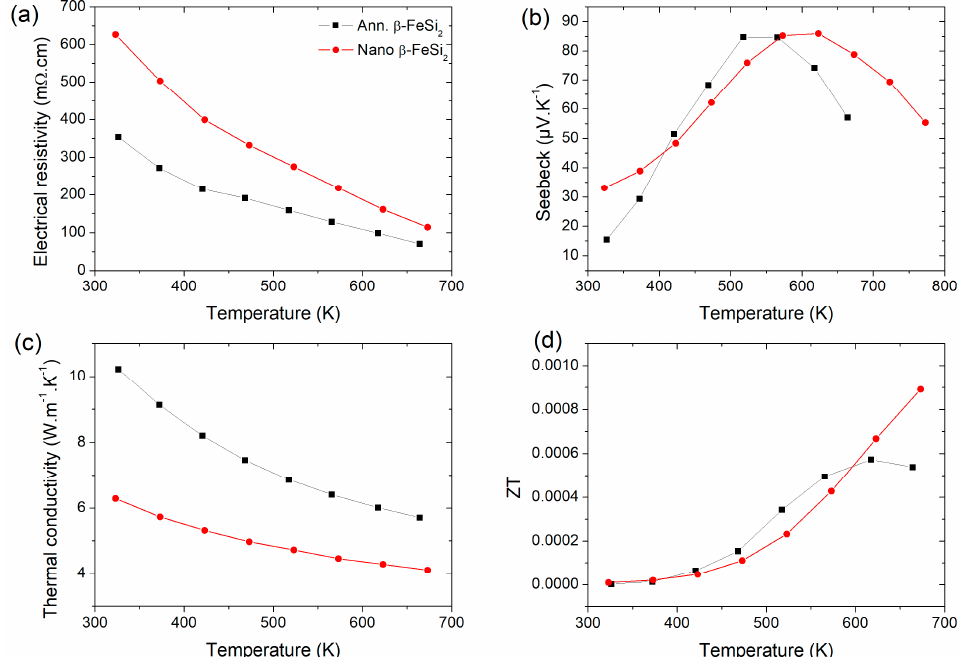
Figure 6. ( a – c ) Thermoelectric properties of annealed S2 ann and nanostructured S2 β -FeSi 2 samples and their ( d ) figure of merit ZT.